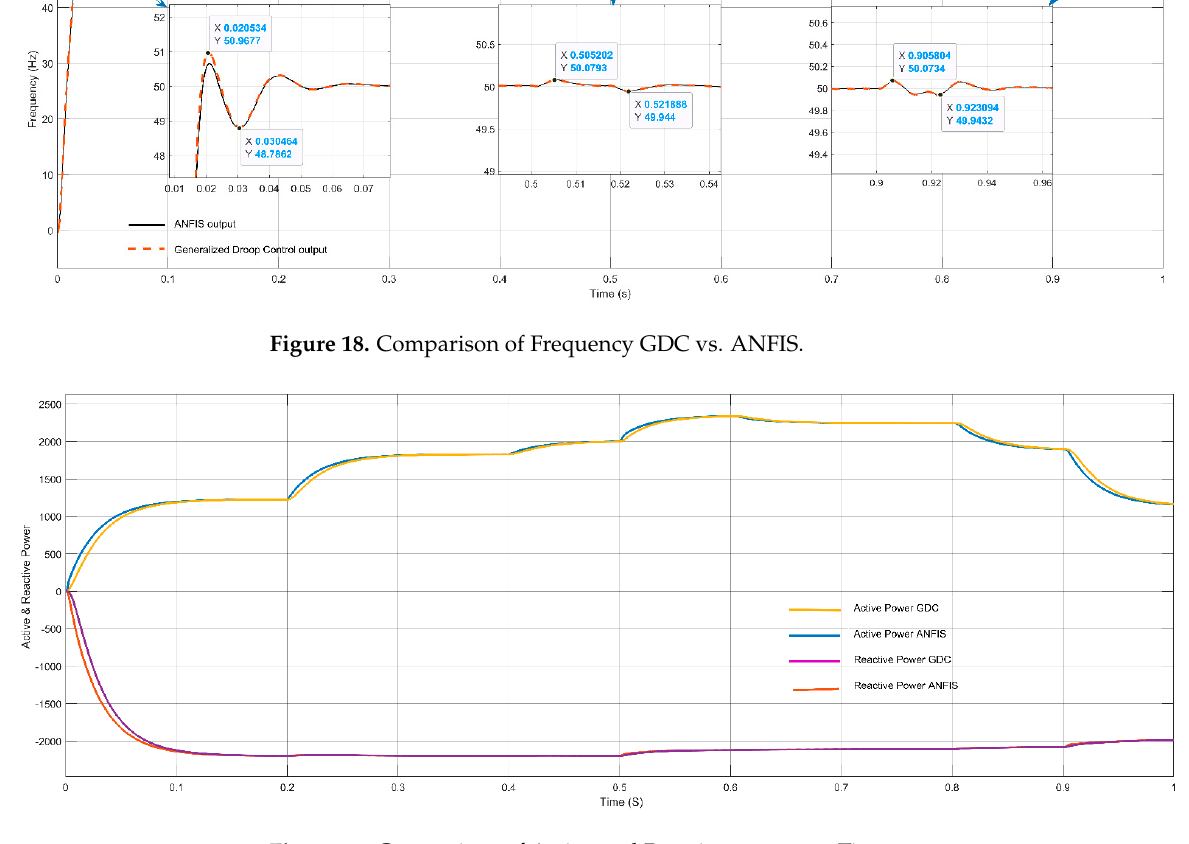
Figure 21. Fuzzy rules. ( a ) P-F ANFIS; ( b ) Q-V ANFIS. ( a ) ( b ) Figure 22. Membership function plot. ( a ) P-F ANFIS; ( b ) Q-V ANFIS. 6. Conclusions In this paper ANFIS-based Droop control technique considering intake microgrid system was analyzed under different loading conditions, which is considered analogous to different loadings of intake system. Similarly, in order to compare and analyze the re- sults, the conventional droop control technique using generalized droop control (GDC) technique has also been considered. Simulation results were shown for different loading conditions. ANFIS has been successfully trained for considering both the cases of P-f and Q-V droop separately. Moreover, the controller block for both the P-f and Q-V droop are replaced with trained ANFIS controllers, and simulations were drawn for different load- ing conditions. GDC seems to show acceptable results under grid connected and islanded mode of operations, the corresponding graphs such as load vs. source power, V&I at PCC, Modulation index, DC link voltage, frequency, and active and reactive power were